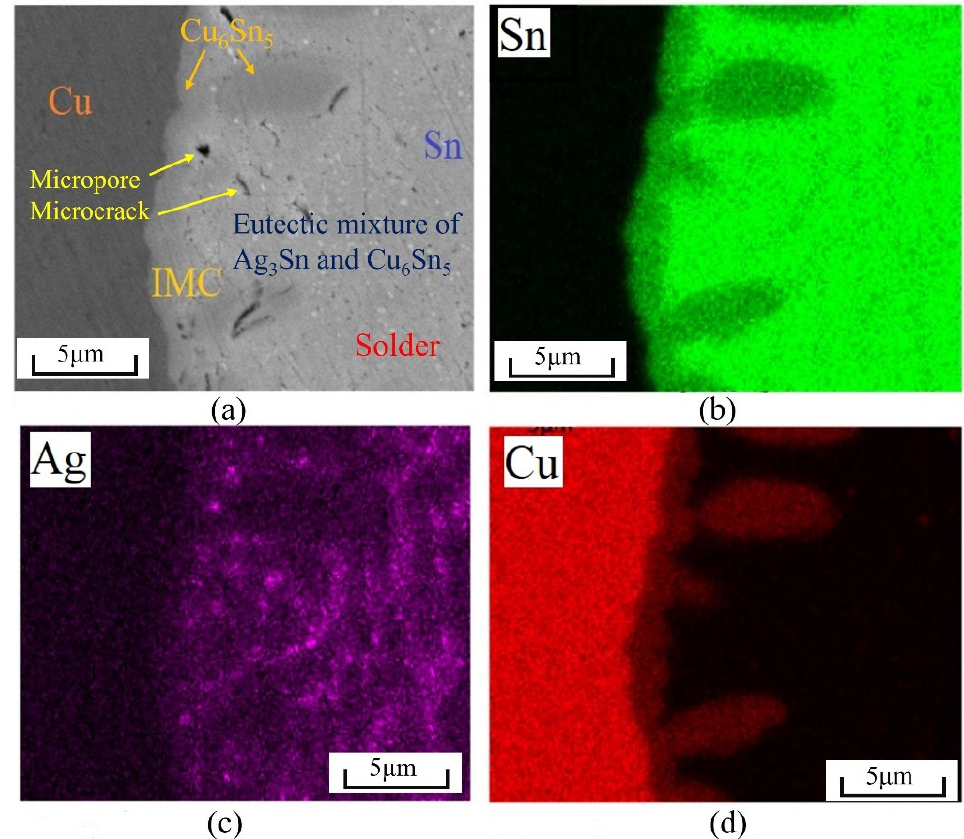
Figure 5. Microstructure and EDS mapping of surface of SAC305/Cu interfaces after polishing. ( a ) initial microstructure; ( b ) Sn element; ( c ) Ag element; ( d ) Cu element.